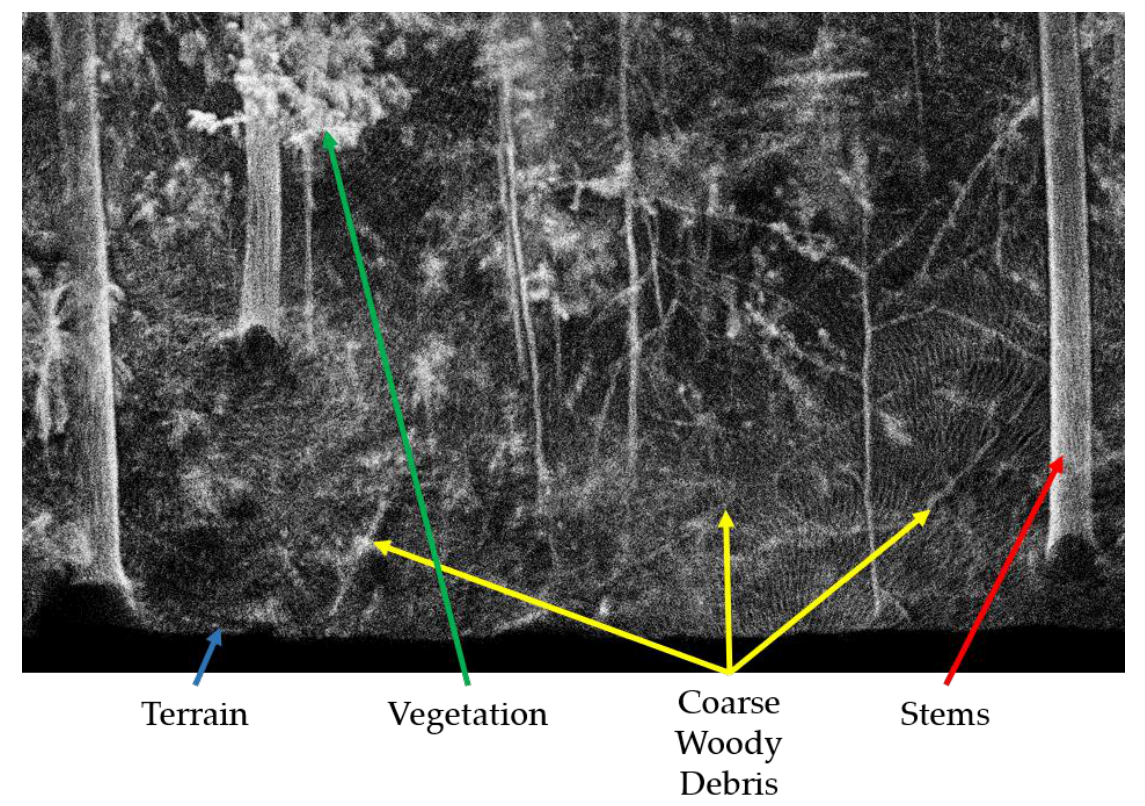
Figure 1. Objects within a Mobile Laser Scanned (MLS) point cloud can still be interpreted with relative ease by a human despite having no color information. We can easily identify which points belong to terrain, vegetation, coarse woody debris, and stems in most cases. While this figure is only two-dimensional (making interpretation more challenging), these objects are considerably more recognizable when viewing the point cloud directly, as it is easier for us to perceive the structure while translating/rotating the point cloud.